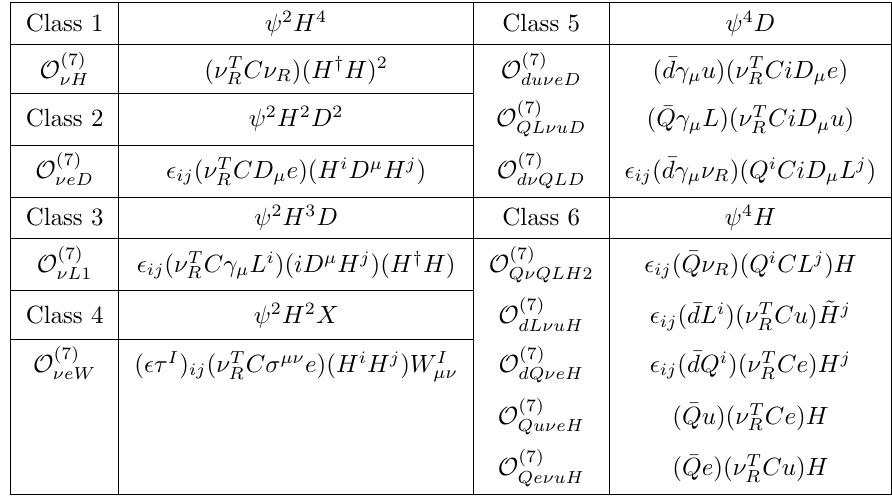
Table 4 . LNV dim-7 operators [76] involving a sterile neutrino that a(cid:11)ect 0 (cid:23)(cid:12)(cid:12) at tree level.